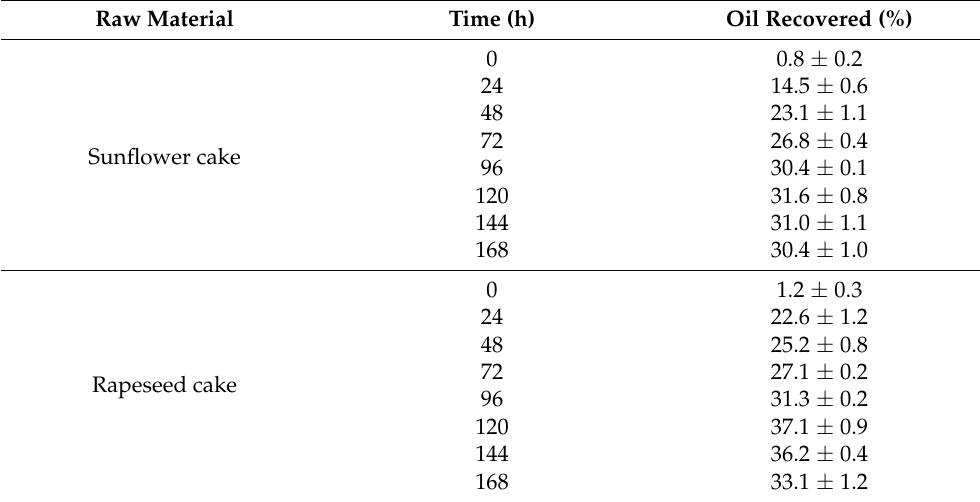
Table 2. Percentages of oil recovered with the biosurfactant produced by B. subtilis #309 in the medium containing 5% sunflower cake or rapeseed